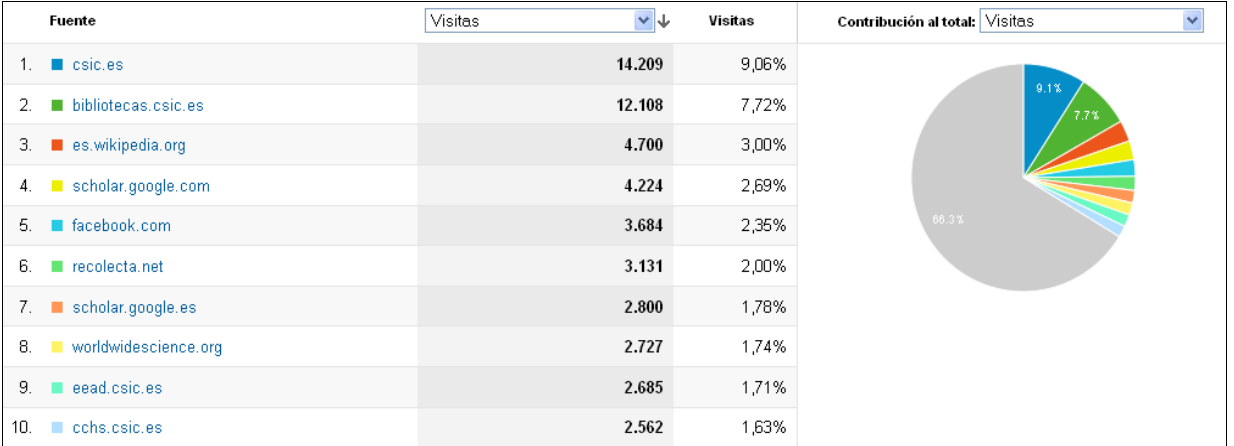
Figure 5. Main search sources (July 2011–April 2013) Source: Google